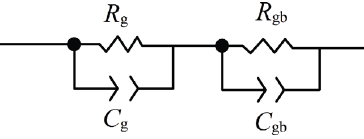
Fig. 4 An equivalent electrical circuit of KNNT–0.055BZ + 0.03Zr + y Mn ceramics. Table 2 Activation energy of E gb , E g , and Δ E